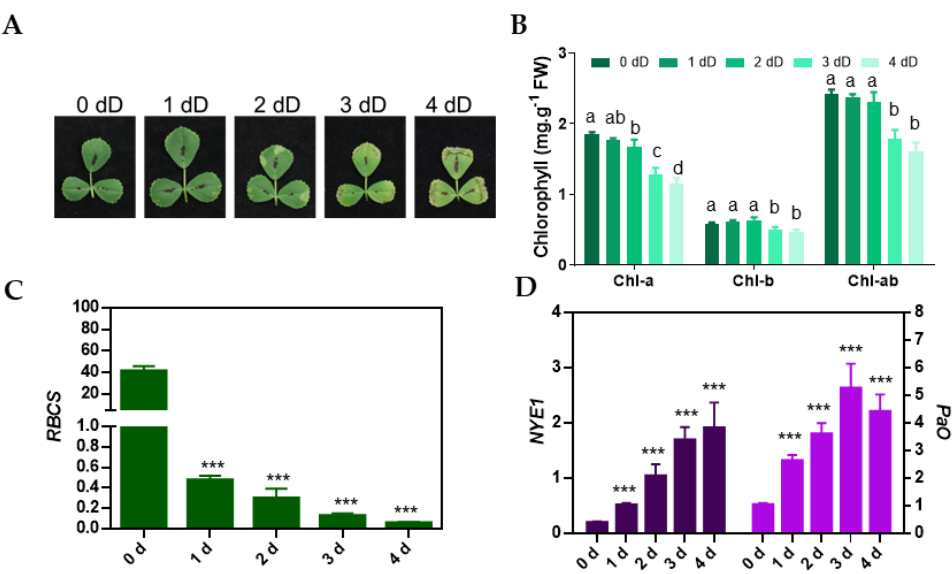
Figure 4. Physiological and molecular analysis of dark-induced leaf senescence. ( A ) Phenotype of M3 trifoliate leaves from 28-day-old plants at 0 d, or after an additional 1 d, 2 d, 3 d or 4 d of dark treatment (dD—days of dark treatment). ( B ) Chlorophyll concentration (Chl-a, Chl-b and total chlorophyll, Chl-ab) in M3 trifoliate leaf at 0 dD, 1 dD, 2 dD, 3 dD and 4 dD. Data represent mean values ( ± SD; n = 3) and were analyzed using one-way ANOVA LSD test ( p < 0.05) and bars with different letters in ( B ) are statistically not similar to each other. Expression analysis of ( C ) photosynthesis-associated genes (PhAG, RBCS ) and ( D ) senescence-associated genes (SAGs, NYE-1 and PaO ), at 0 dD, 1 dD, 2 dD and 3 dD. Data in (C) and (D) represent mean values (±SD; n = 3), and were analyzed using Student’s t -test (*** p < 0.001) against 0 dD time point.